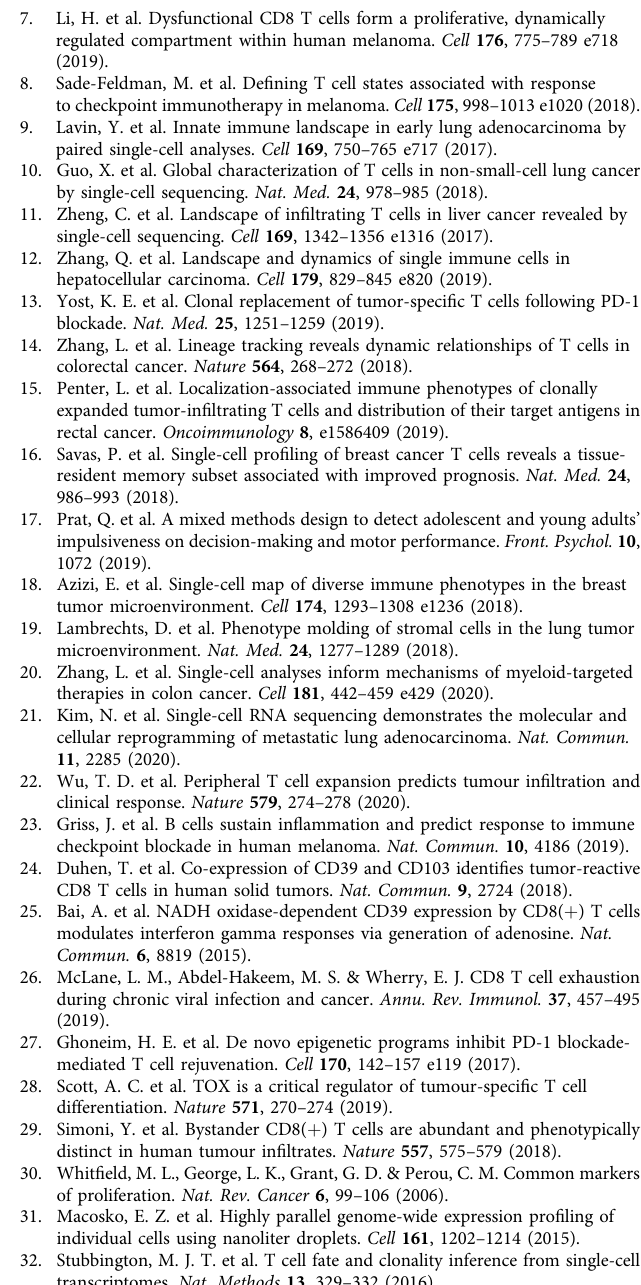
Fig. 7 Ligand – receptor-based interaction between immune cells in ESCC. a Circos plot showing the predicted average strength in seven patients of the indicated interaction between macrophage-provided ligands and receptors in other cell types within tumor or adjacent tissues. b Violin plot showing the average expression value of a given gene in CD4-C6-FOXP3 from the tumor and adjacent tissues. The expression was measured as the log2 (count + 1), two-tailed Wilcoxon test. c Expression levels of relative marker genes across NK-T cells illustrated in UMAP plots, the expression was measured as the log2 (count + 1). d Detection of CD4, Foxp3, and IL1RII in ESCC tissue by multi-color IHC staining. Representative data from three patients was shown. e , f CD4 + CD25 − (Teff) cells were stimulated with IL1 β , Treg cells were co-cultured with Teff cells in the presence of anti-IL1R2 or IgG antibodies, the percentage of Teff dividing cells ( n = 6) e and the IFN γ expression in Teff cells ( n = 4) f was measured by FACS after 72 h culture. g Circos plot showing the predicted interaction strength of the indicated L – R pairs between tumor and adjacent tissues as Treg-provided ligands and interactions with the indicated cell types averaged across seven patients. h Violin plot showing the average LILRB1 expression in macrophages from tumor and adjacent tissues. The expression was measured as the log2 (count + 1), two-tailed Wilcoxon test. i FACS analysis of LILRB1 expression in CD68 + macrophage cells from adjacent and ESCC tumor tissues ( n = 3). j Detection of CD4, Foxp3, CD68, and LILRB1 in ESCC tissue by multi-color IHC staining. Representative data from three patients was shown. k , l Macrophages were co-cultured with or without Treg cells, and fl ow cytometry measured the expression of CD163, CD206, and PDL1. Representative data from four patients was shown k and TNF α expression. Representative data from three patients was shown ( n =